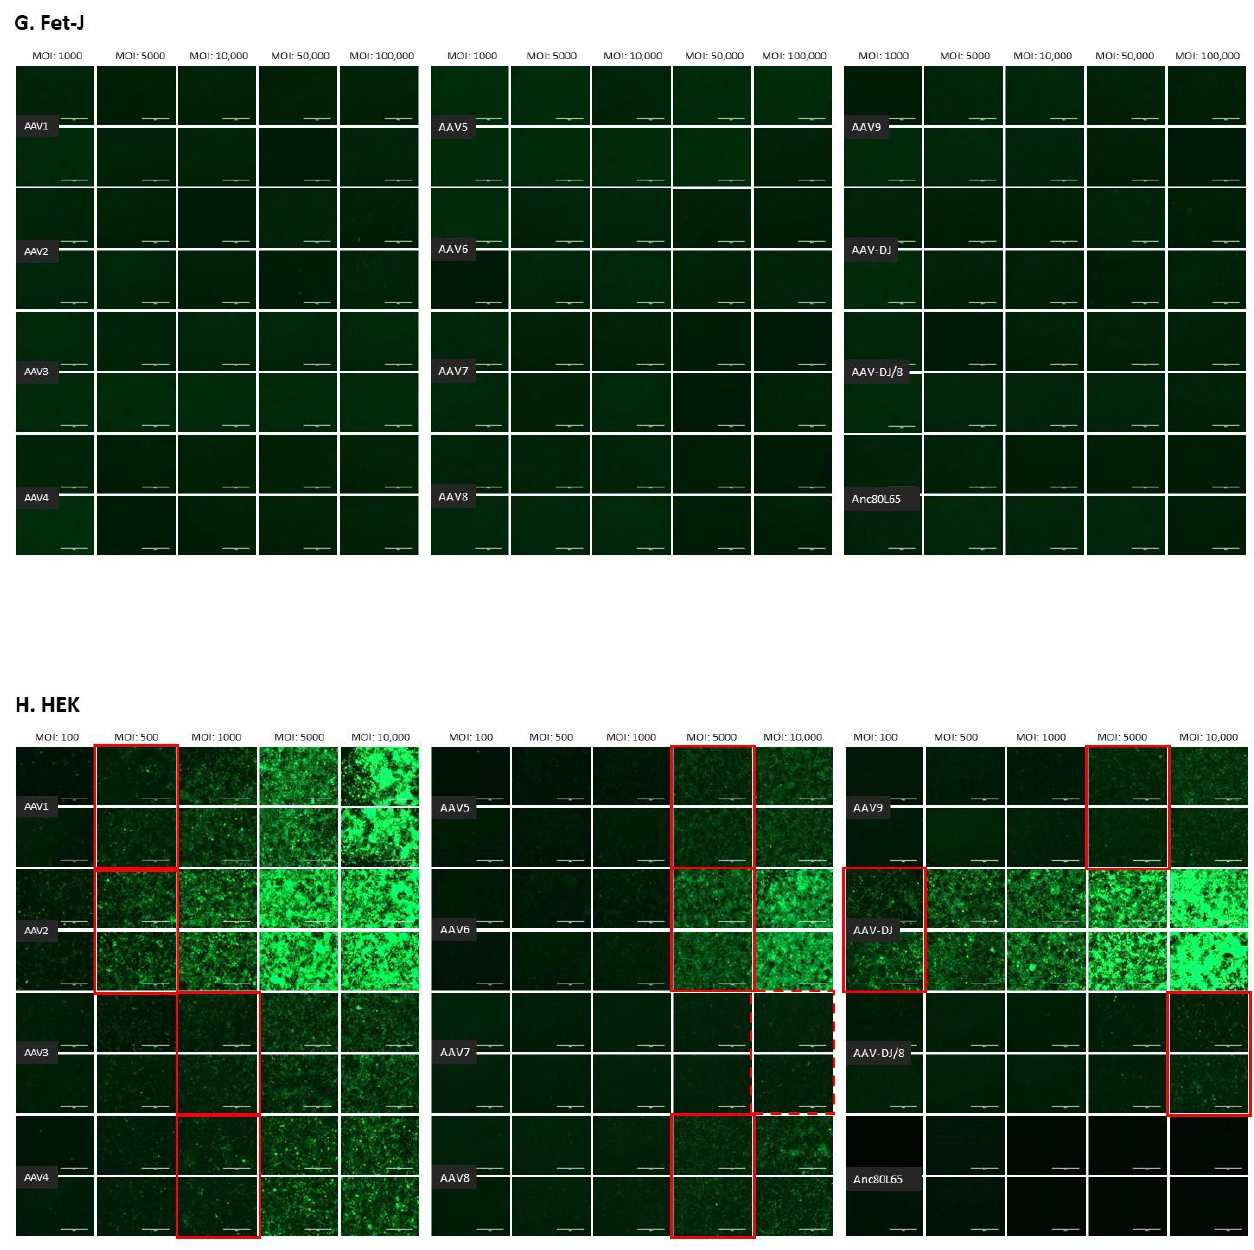
Figure A2. Fluorescent microscopy images of cells infected with 12 AAV serotypes. ( A ) FEA, ( B ) PG-4, ( C ) AK-D, ( D ) MT, ( E ) Fc3Tg, ( F ) Fcwf-4, ( G ) Fet-J, and ( H ) HEK cells infected with 12 AAV serotypes. Infection of nine natural AAV serotypes (AAV1-9), two AAV hybrid strains (AAV-DJ and AAV-DJ/8), and Anc80L65, all EGFP tagged from the upper left to the lower right, using a multiplicity of infection (MOI) between 100 and 100,000 (specific MOI depended on the cell line) after 3 days. Red squares mark the minimal MOI at which a significant AAV infection could be visualized for each AAV serotype by fluorescence (corresponding to ≥ 50% infection); red dashed squares represent the minimal MOI, at which a EGFP signal was clearly visible, but not reaching 50% infection. The bars represent 400 µm.